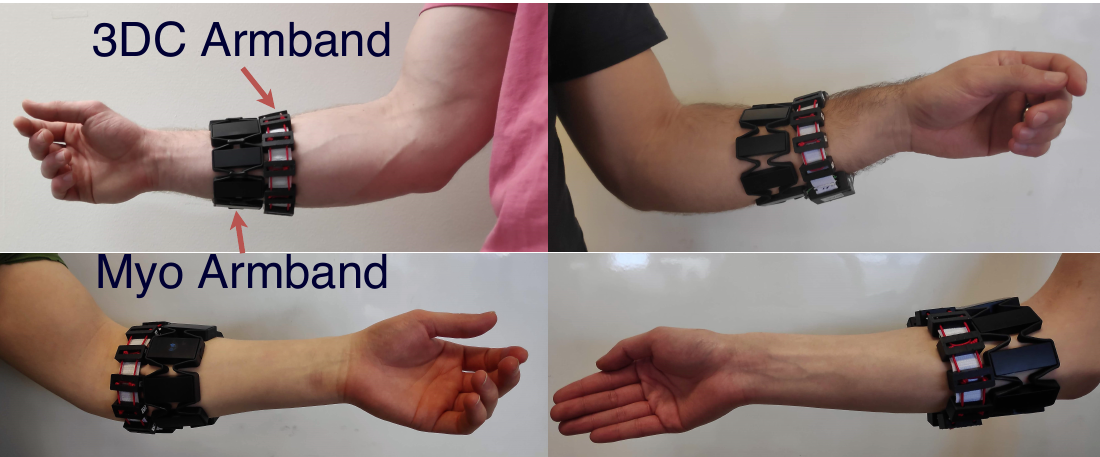
Figure 6. The two different armband configurations (left/right) employed in this work with the 3DC being either above or below the Myo armband with respect to the participant’s wrist. This figure also showcases the wide variety of armband positions recorded in the proposed dataset.